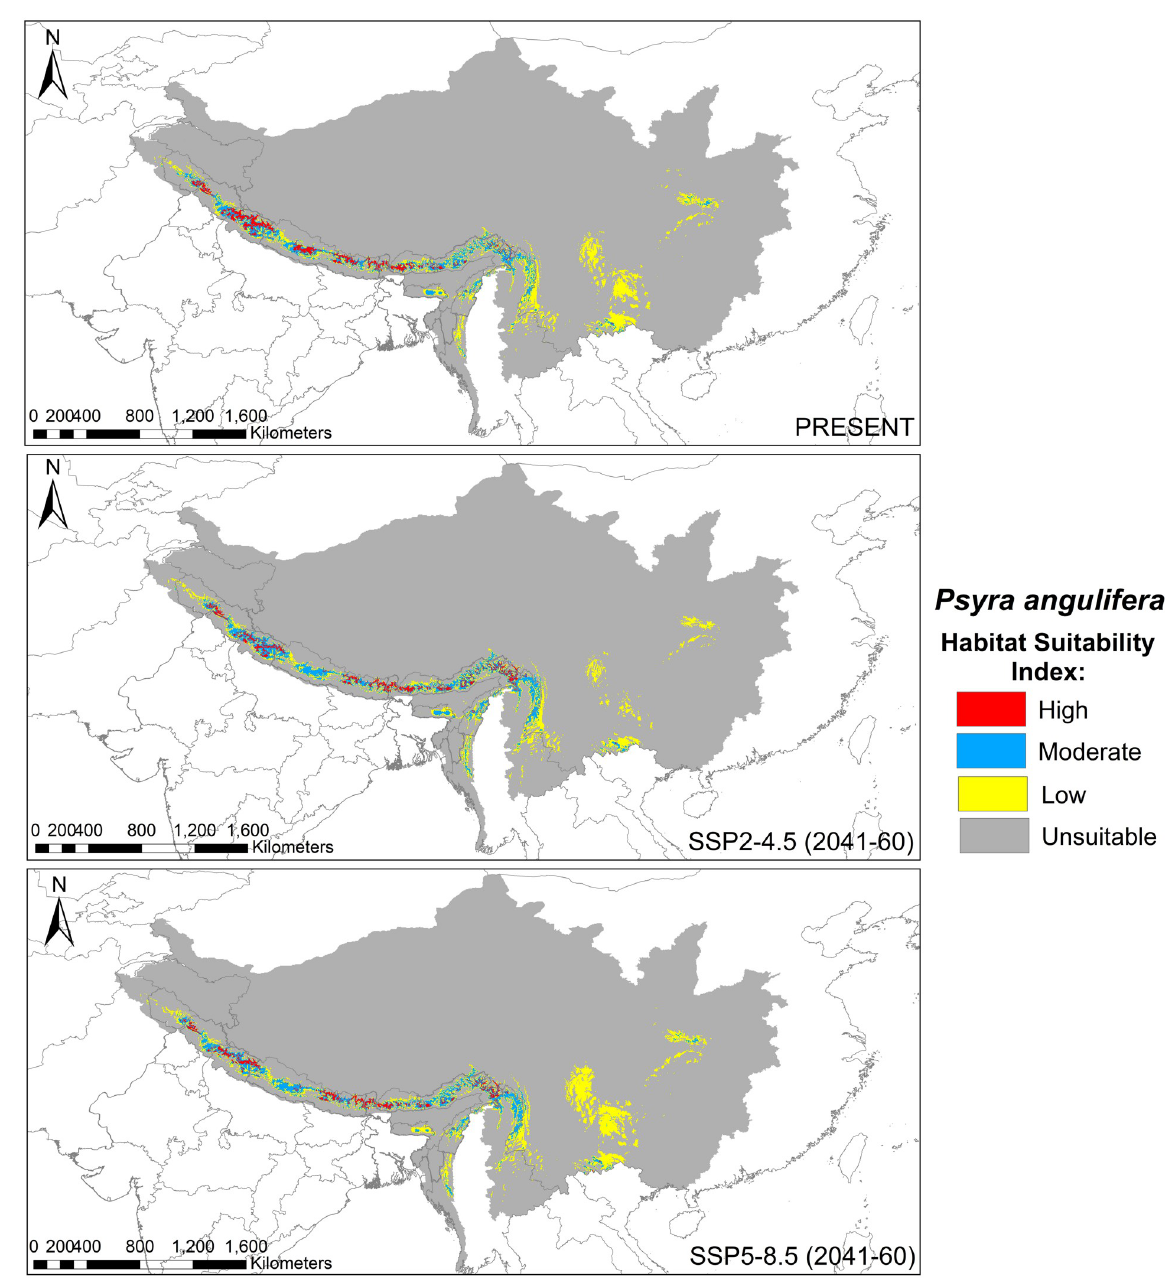
Fig 18. Predicted habitat suitability of Psyra angulifera under current (1970–2000) and two future climatic scenarios SSP2-4.5 and SSP5- 8.5 in the year 2041–60 based on MaxEnt species distribution model.